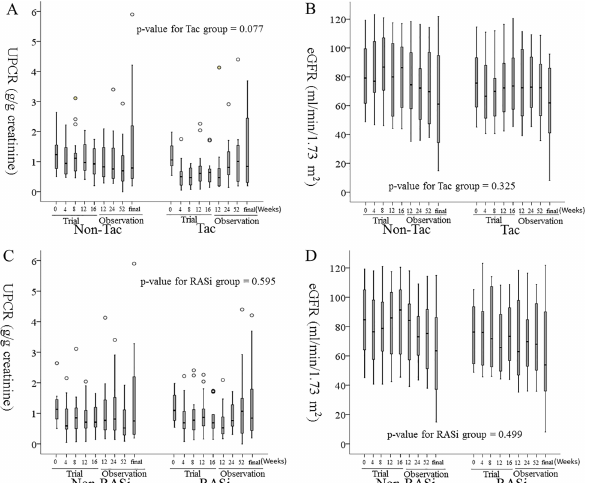
Fig 2. The changes in UPCR (A, C) and eGFR (B, D) during the follow-up period after cessation of the clinical study. From left to right, each box-plot represents the follow-up periods of 0-weeks, 4-weeks, 8-weeks, 12-weeks and 16-weeks of the trial phase, and 12-weeks, 24-weeks, 52-weeks, and the final visit by October 2016 of the observational phase. A. The p-value for tests of between two groups was 0.130. B. The p-value for tests of between-subjects effects was 0.543. C. The p-value for tests of between-subjects effects was 0.830. D. The p-value for tests of between-subjects effects was 0.488. Tac: Tacrolimus, RASi: renin-angiotensin-aldosterone system inhibitor, UPCR: urine protein to creatinine ratio, eGFR: estimated glomerular filtration rate by the equation of CKD-EPI. The p-value estimated by linear mixed effect model.